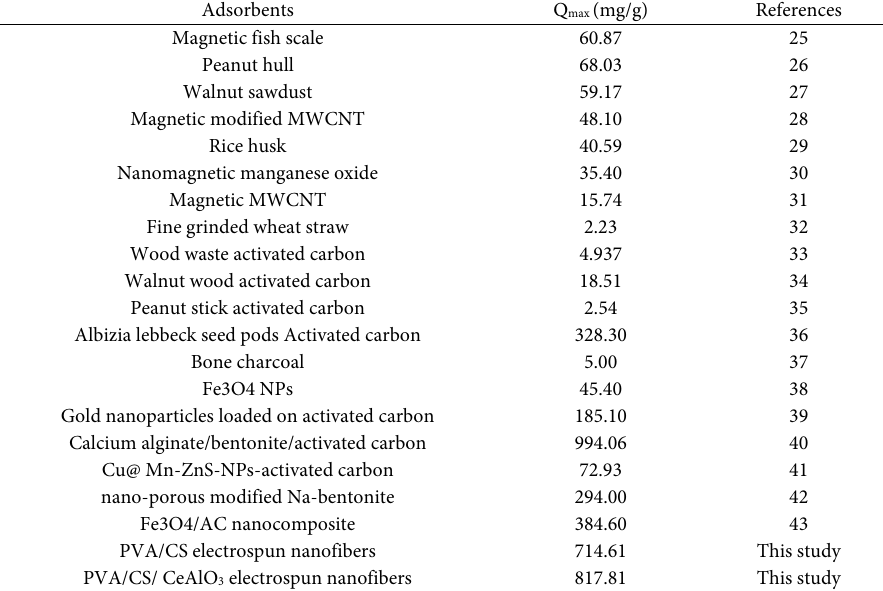
Table3. Comparison of the maximum adsorption capacities of MB dye onto various